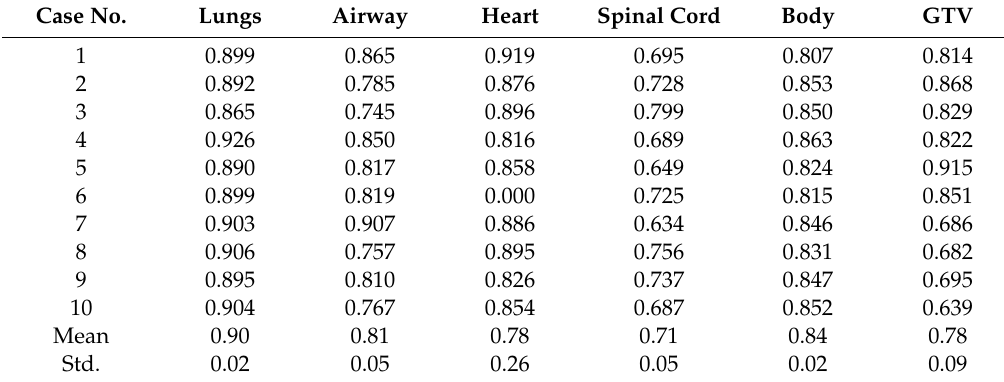
Table 3. Dice coe ffi cients of six targets in Dataset II.